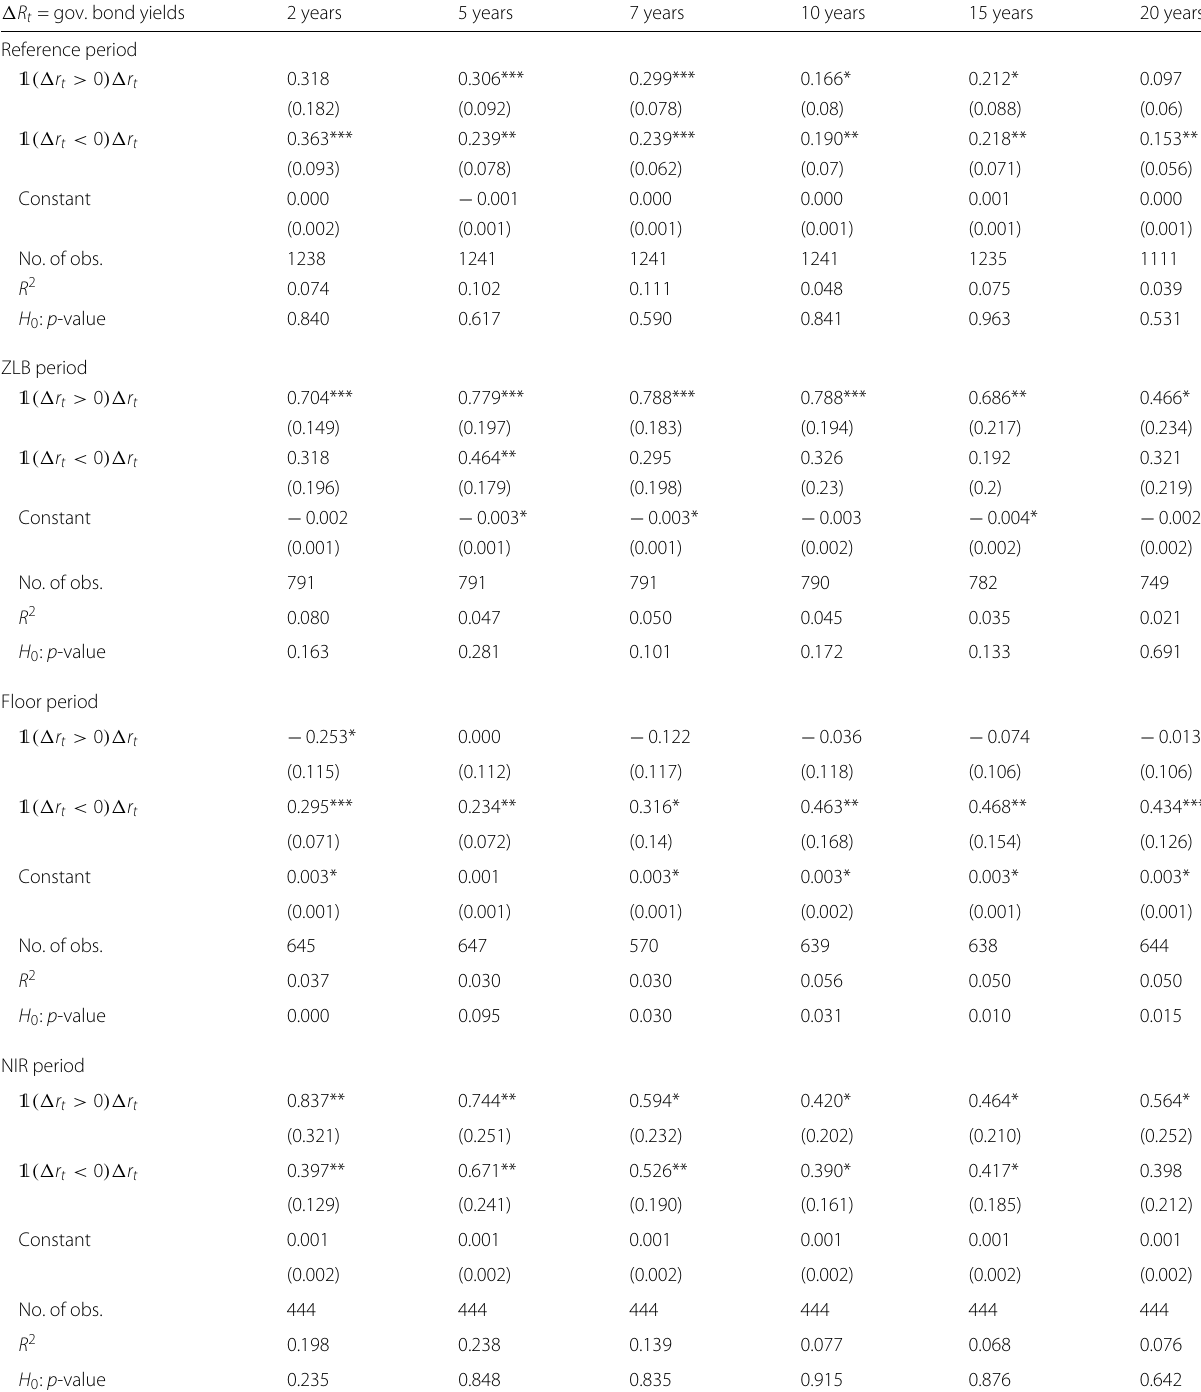
Table 3 Robustness: additional control